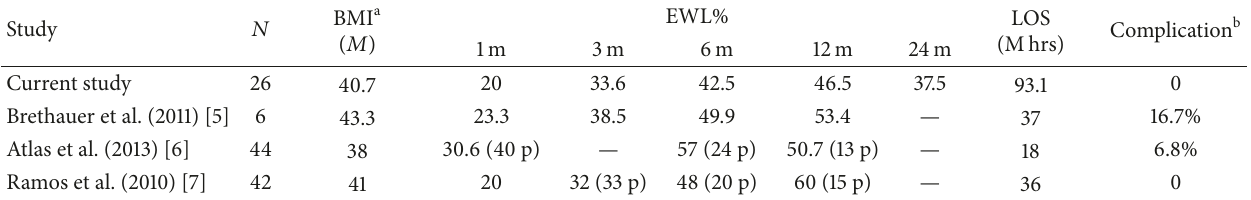
Table 2: Comparison of findings of the current study with the literature.